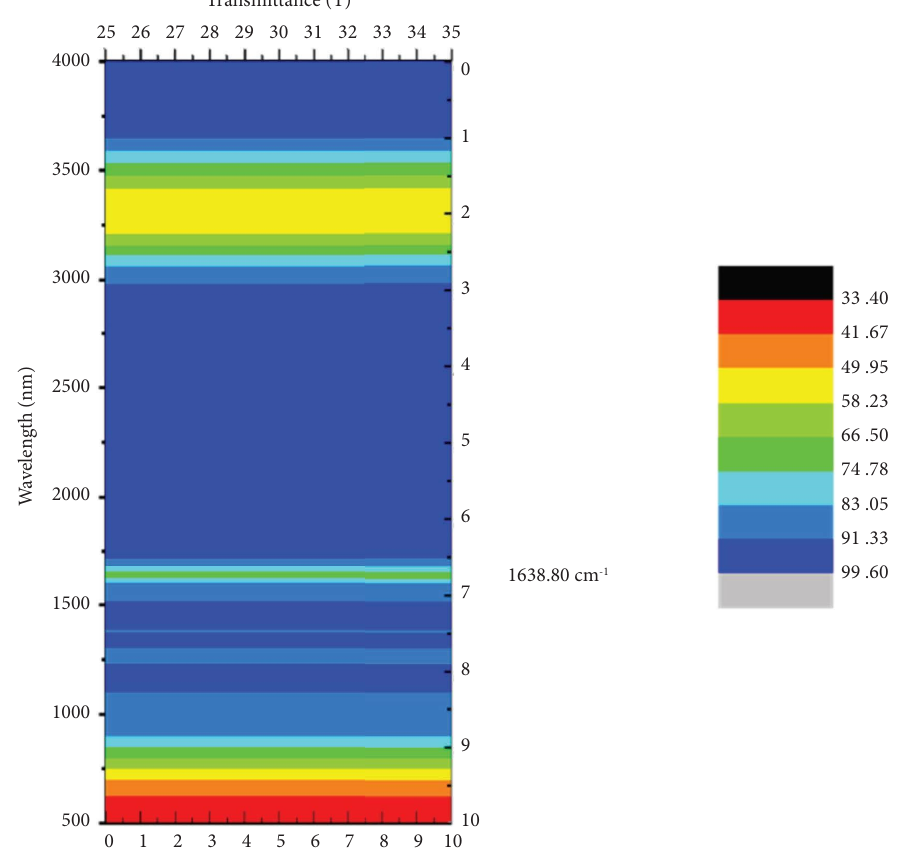
Figure 2: FTIR analysis of green synthesized silver nanoparticles.